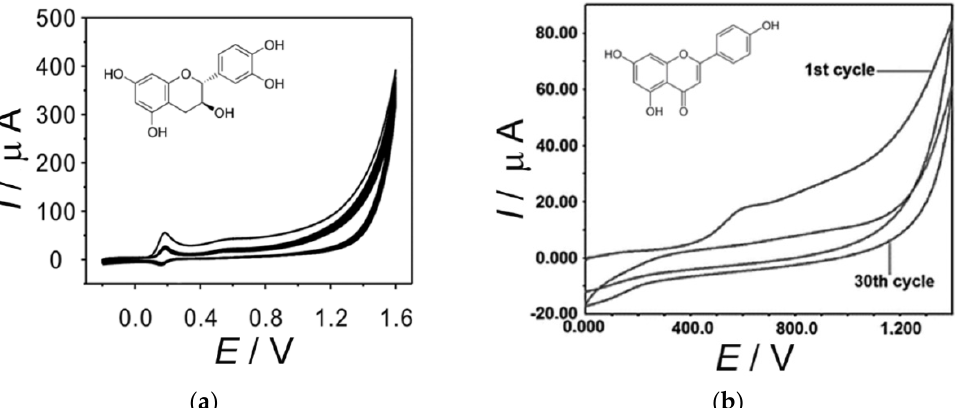
Figure 2. ( a ) Cyclic voltammograms of 1.0 mM catechin at activated CPE in 0.1 M phosphate buffer pH 7.4. Reprinted with modification from [44] with permission from the Royal Society of Chemistry; ( b ) cyclic voltammograms of 1.0 mM apigenin at GCE in 1:4 methanol − phosphate buffer mixture pH 7. Reprinted with modification from [47] with permission from the Royal Society of